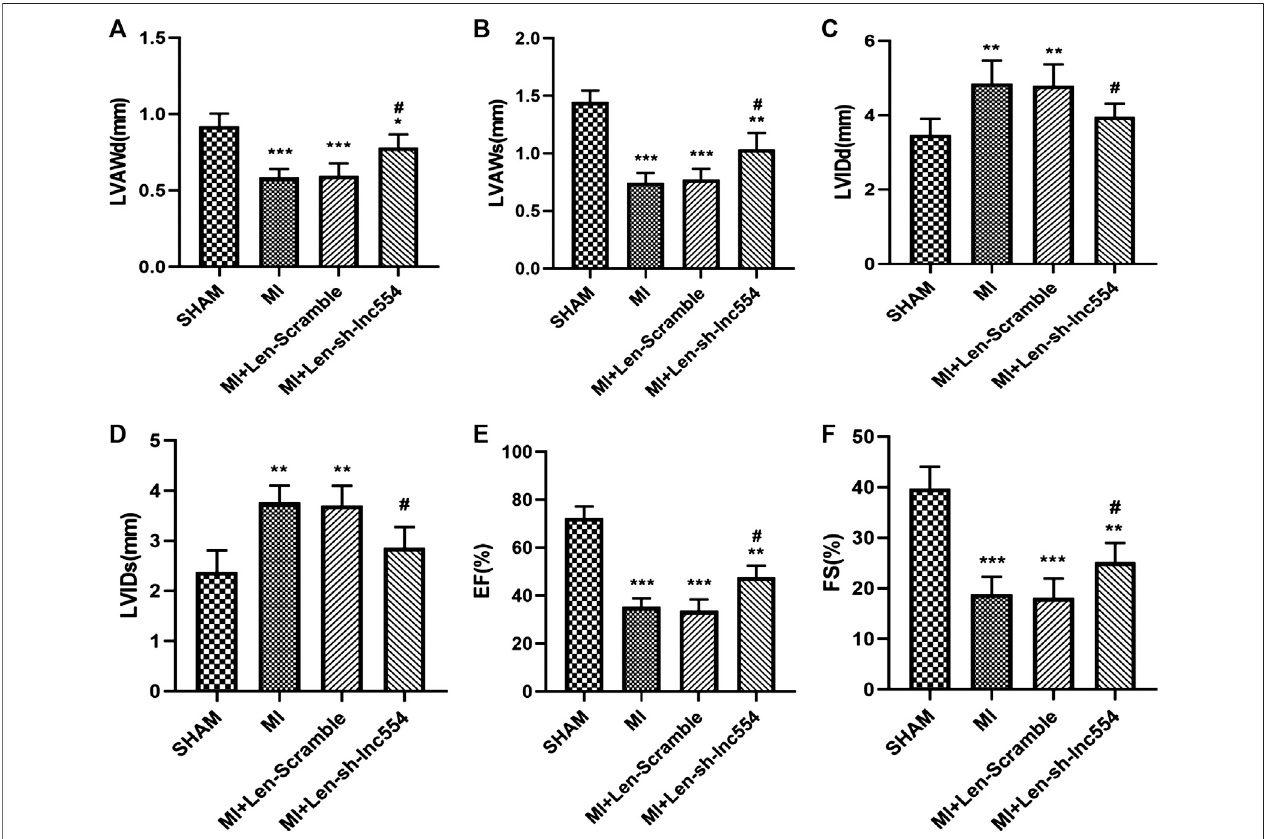
FIGURE 5 | Knockdown of lncRNA 554 improves cardiac function of infarcted hearts. The hearts were injected with lentivirus containing control or lncRNA 554 shRNA after MI. Two weeks after MI, ventricular parameters were measured and analyzed by echocardiography, including LVAWd; (A) , LVAWs; (B) , LVIDd; (C) , LVIDs; (D) , left ventricular EF; (E) , and FS; (F) . Data are presented as mean ± SEM. * p < 0.05, ** p < 0.01, *** p < 0.001 vs SHAM group; # p < 0.05, ## p < 0.01 vs MI + Len- Scramble group, n (cid:2) 8. EF: ejection fraction; FS: fractional shortening; LVAWd: left ventricular anterior wall end diastolic thickness; LVAWs: left ventricular anterior wall end systolic thickness; LVIDd: left ventricular internal diastolic diameter; LVIDs: left ventricular internal systolic